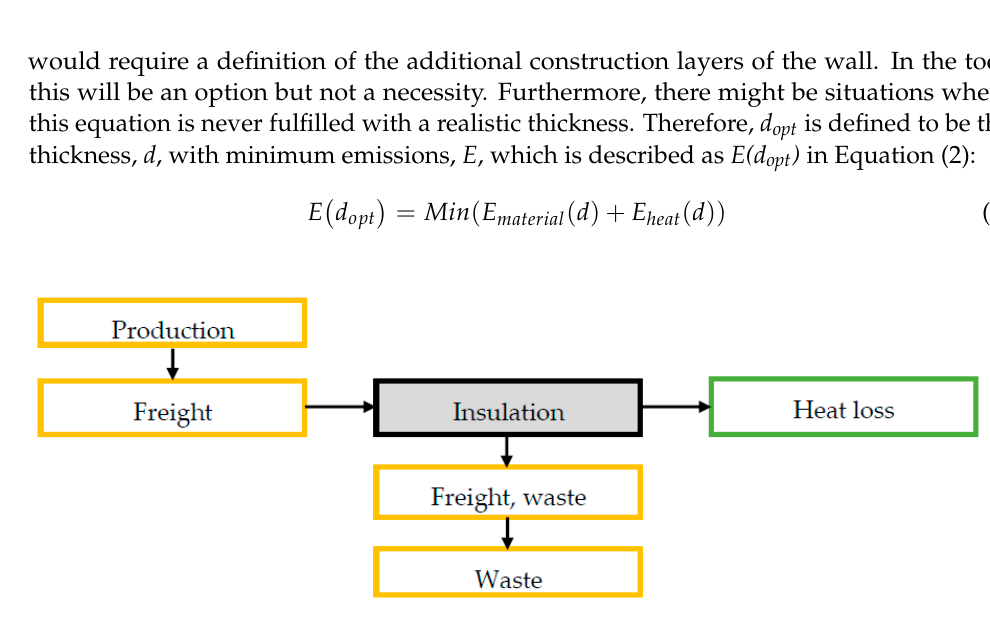
Figure 1. Flow chart of the product system for the insulation material (gray box). The colors indicate whether the process results in emissions related to the material, E material , (yellow) or the resulting heat loss, E heat , (green).